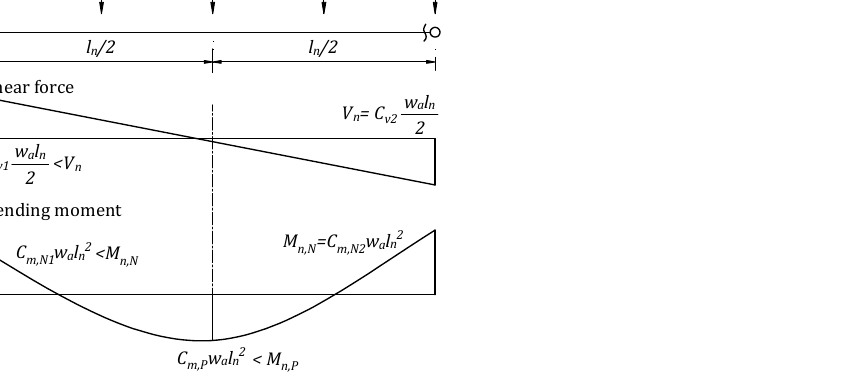
Figure A8. The failure mechanism for B-1 region; shear failure at N2 section after forming a plastic hinge at the N2 section.